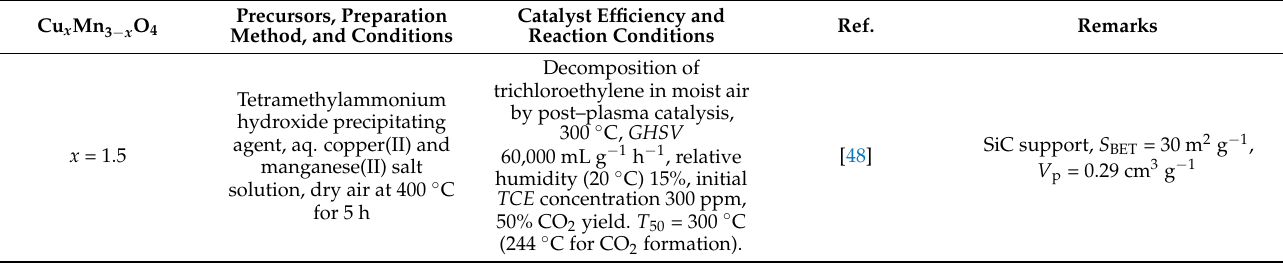
Table 7. Removal of chlorinated hydrocarbons from air in the presence of Cu x Mn 3 − x O 4 catalysts. Cu x Mn 3 − x O 4